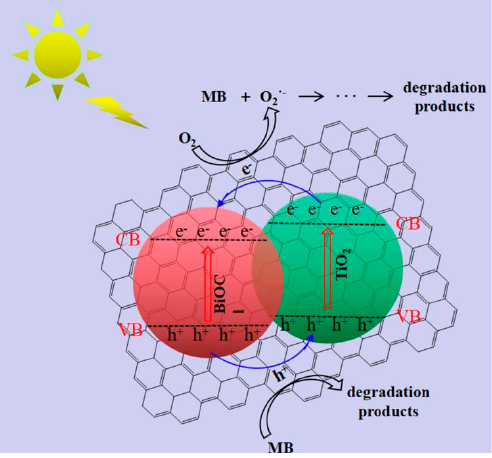
Figure 11. Proposed mechanism of photocatalytic activity by RGO/BiOCl/TiO 2 nanocomposites.